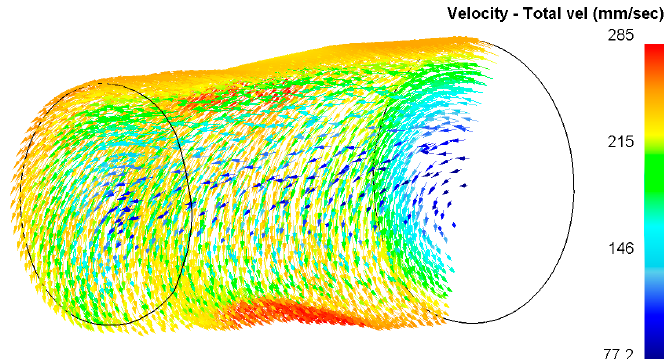
Figure 7. Character of metal flow during radial-shear rolling.